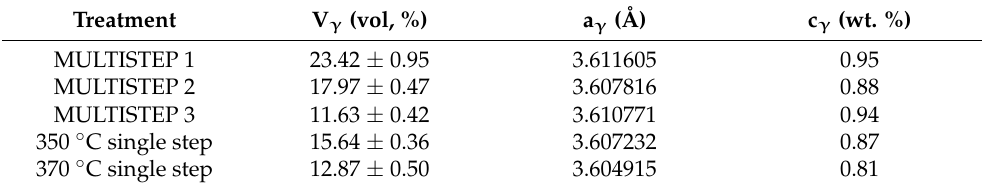
Table 5. Variations in volume fraction of retained austenite and carbon concentration (c γ ) as a function of the austempering cycle of the investigated